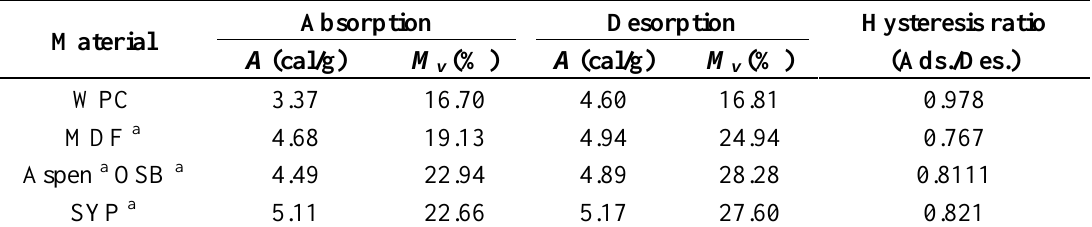
Table 2. Parameters of Nelson’s sorption isotherm for different